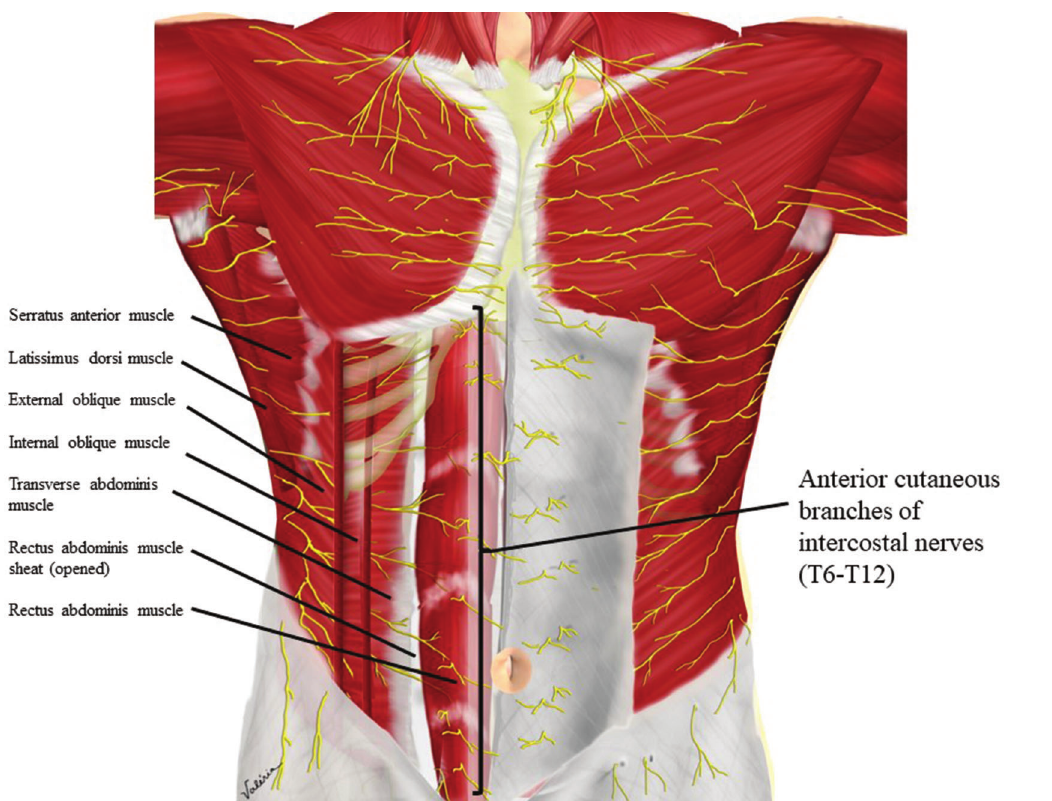
Figure 1 - Innervation of the anterolateral abdominal wall.